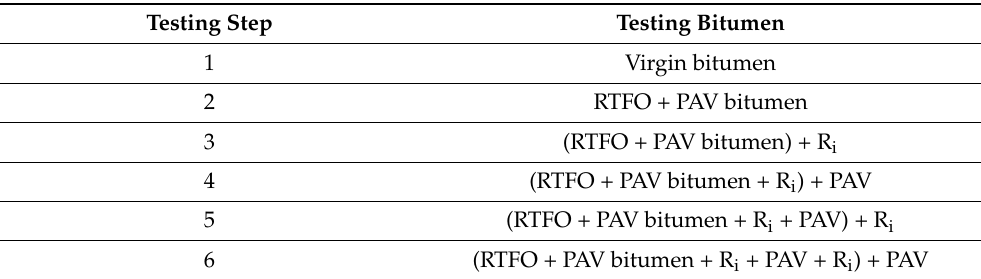
Table 3. Testing steps and the corresponding